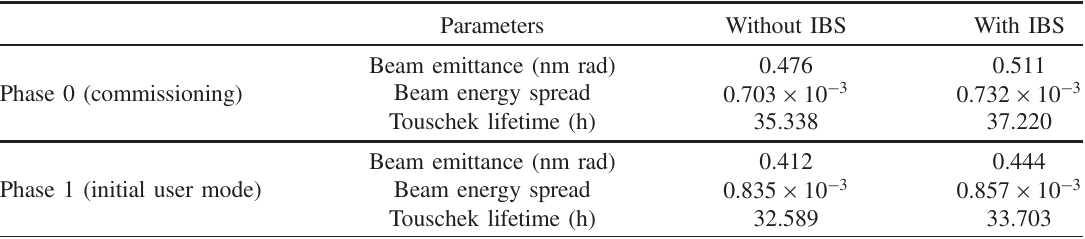
TABLE VI. Equilibrium horizontal beam emittance, beam energy spread and Touschek lifetime calculated with ELEGANT [13] code with and without IBS effect.